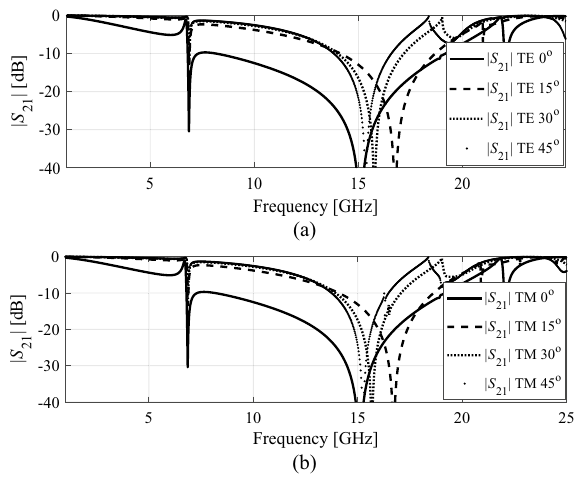
Figure 8. Design 1: ( a ) transmission coefficients for TE mode, ( b ) transmission coefficients for TM mode at different incidence angles.